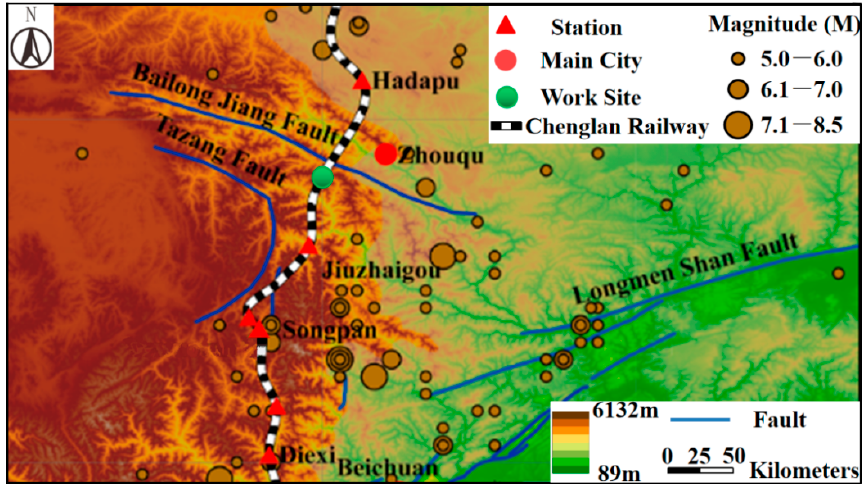
Figure 1. Seismic distribution and fault zones of the Chenglan railway.